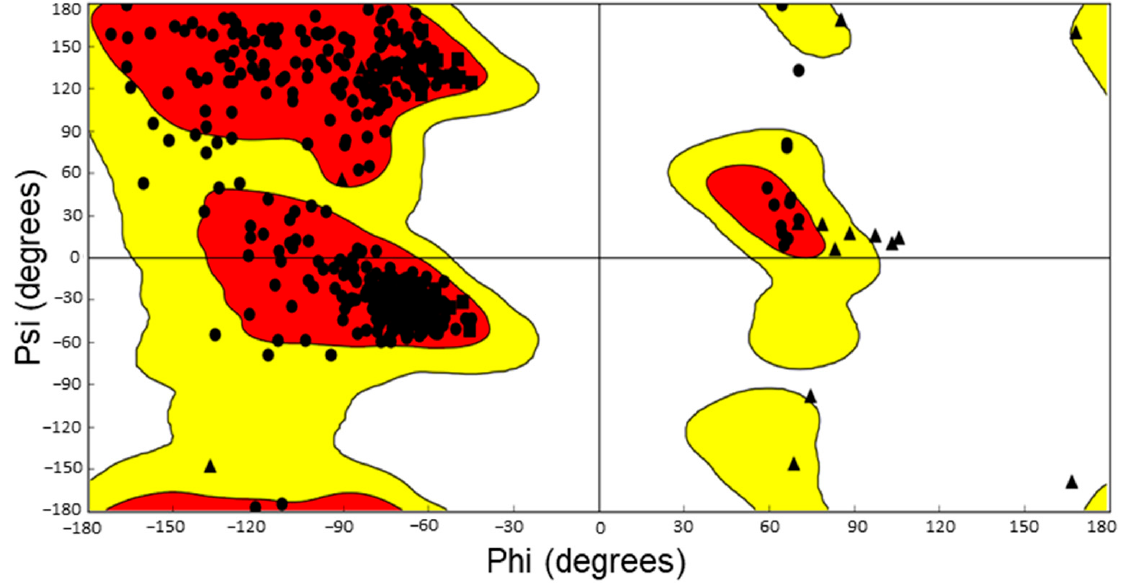
Figure 1. Ramachandran plot of the minimized protein. The ‘red color’, ‘yellow color’, and ‘white color’ regions represent the favored, acceptable, and unfavored regions, respectively. A few amino acids, including VAL190, GLY218, GLY161, and GLY28, are present in the unfavored region.